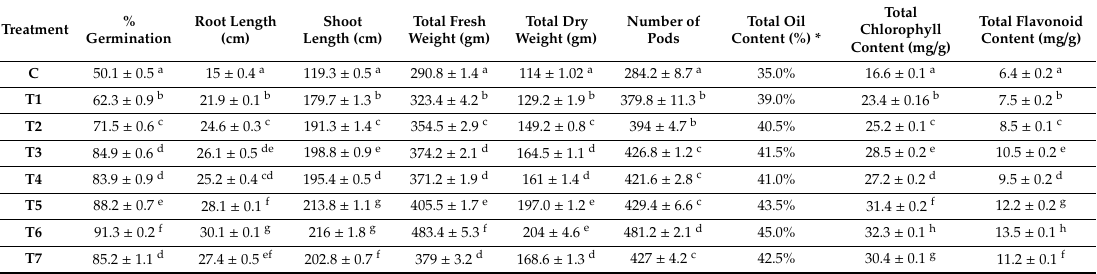
Table 1. E ff ects of inoculation of di ff erent treatments on growth parameters of B. jumcea.